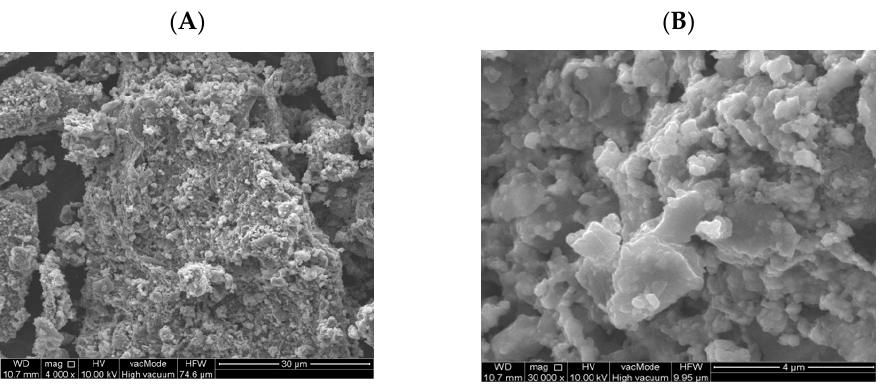
Figure 9. Volumetric distribution of the particle fractions of fly ash from thermal treatment of sew- age sludge.